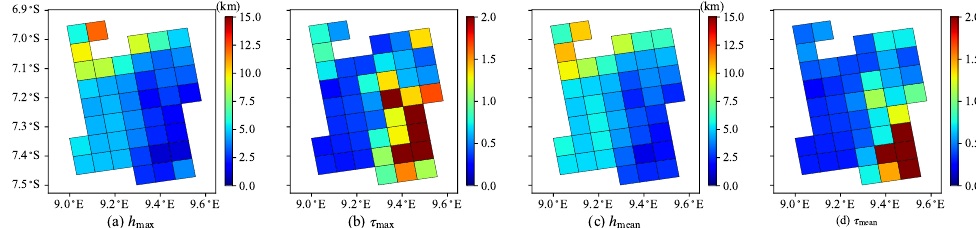
Figure 16. The maximum solution estimates ( h max , τ max ) and the mean solution estimates ( h mean , τ mean ) for Set 2 and data on 4 July